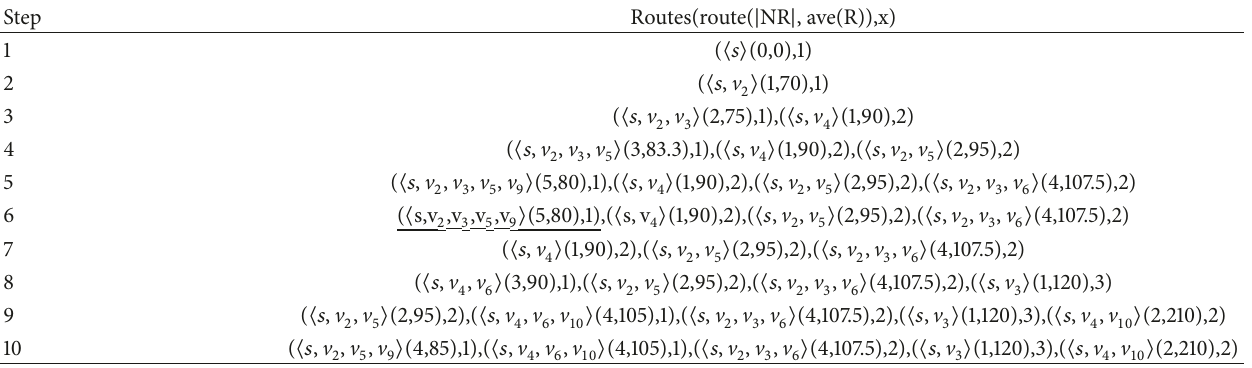
Table 5: Running example of Algorithm 1 for Figure